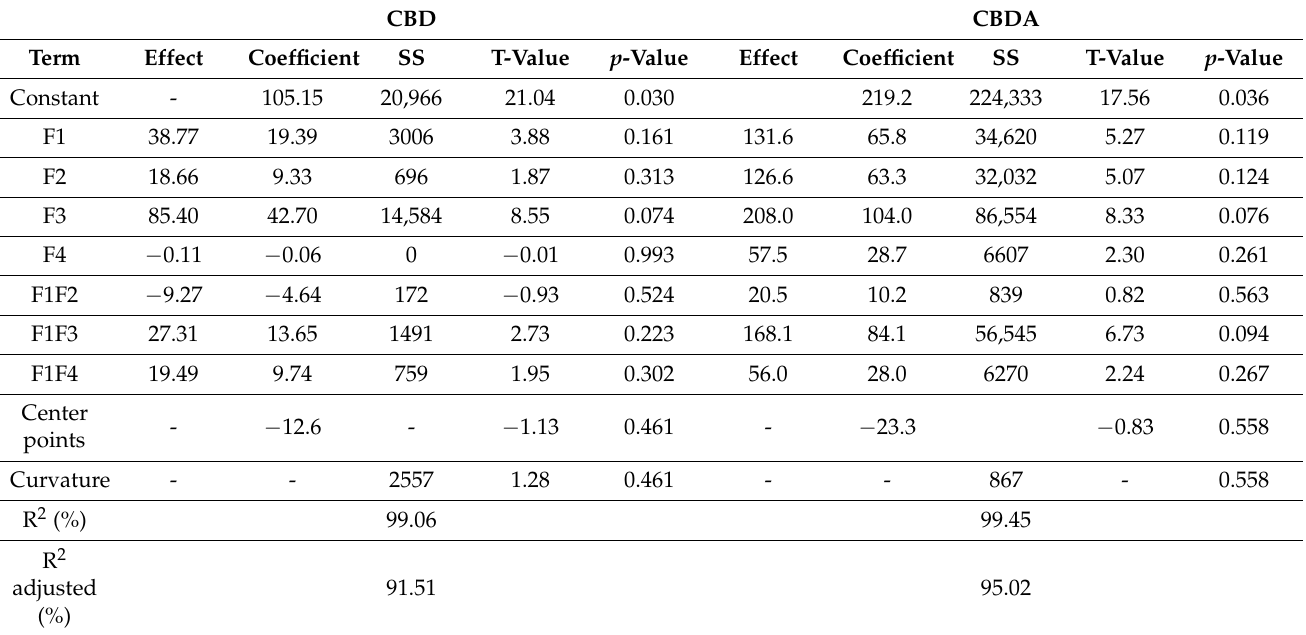
Table 5. FFD statistical analysis: estimated coefficient and effects for cannabidiol (CBD) and cannabid- iolic acid